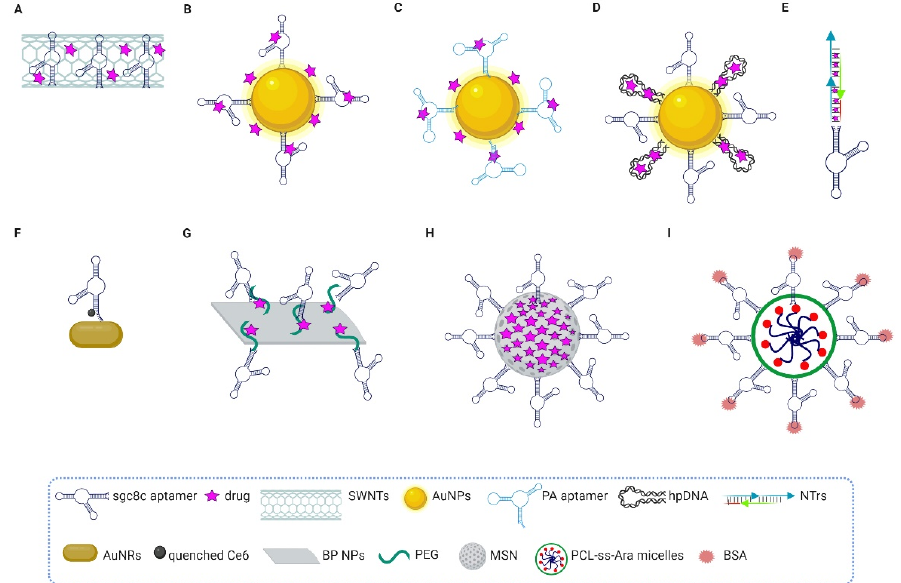
Figure 4. Schematic representation of the anti-PTK7 sgc8c aptamer-based conjugates. ( A ) sgc8 SWNTs/Dau. The sgc8 aptamer and Dau were loaded onto SWNTs through a π electron interaction. ( B ) sgc8-AuNPs/Dau. Sgc8 aptamer was assembled onto the surface of AuNPs and Dau was adsorbed on the surface of AuNPs by electrostatic interaction; a small amount of drug binds to sgc8, because of intercalating characteristic of Dau. ( C ) PA-AuNPs/Dau. A modified polyvalent aptamer and Dau were loaded onto the surface of AuNPs, as described in ( B ). ( D ) sgc8-hpDNA-AuNPs/ doxorubicin (Dox). Sgc8 and a d(CGATCG)-rich hpDNA, in which Dox is intercalated, were assem- bled onto the surface of AuNPs through standard gold-thiol chemistry. ( E ) sgc8-tethered DNA na- notrains (aptNTrs)/drug. AptNTrs obtained by self-assembly of the sgc8, modified on the 5 ′ -end with a DNA trigger (red line), and two hairpin monomers (M1 and M2, blue and green arrows, respectively), and loaded with anthracycline anticancer drugs (Dox, Dau or epirubicin (EPR)). ( F ) sgc8-Ce6/AuNRs. The photosensitizer Ce6 was connected to the 3 ′ -end of sgc8, containing a sulfhy- dryl group at the 5 ′ -end for attachment to AuNRs. ( G ) sgc8-BP NS-PEG/Dox. Sgc8 was covalently conjugated onto the surface of BP NS, modified with PEG and loaded with Dox through electrostatic adsorption. ( H ) sgc8-MSN/Dox. Dox was encapsulated in MSN, which was decorated with car- boxyl-modified sgc8. ( I ) sgc8-BSA/PCL-ss-Ara. The sgc8-bovine serum albumin (sgc8-BSA) deco-